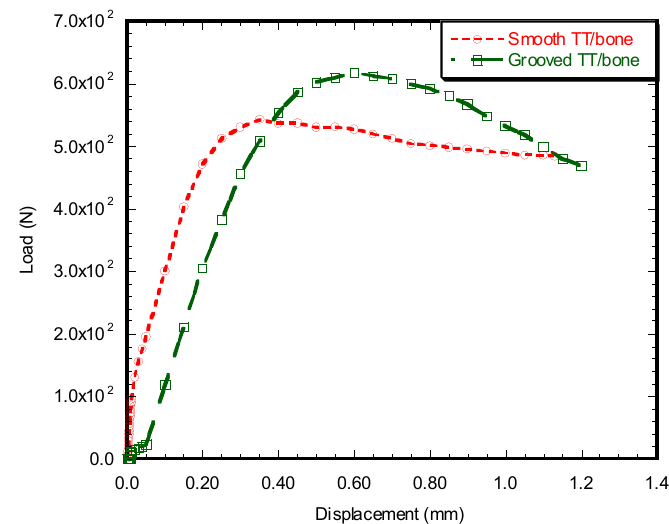
Figure 10. Load vs. displacement plot of smooth TT–bone and grooved TT–bone samples under compression load.